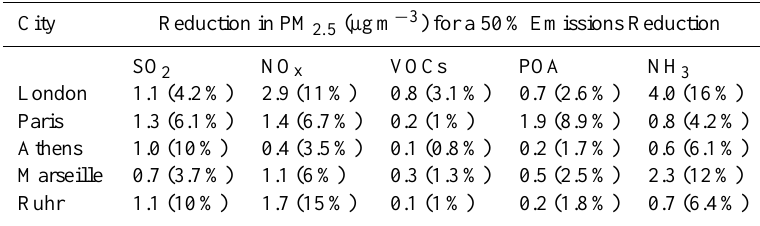
Table 3. Predicted PM 2 . 5 Concentrations Reduction in Selected Cities for May